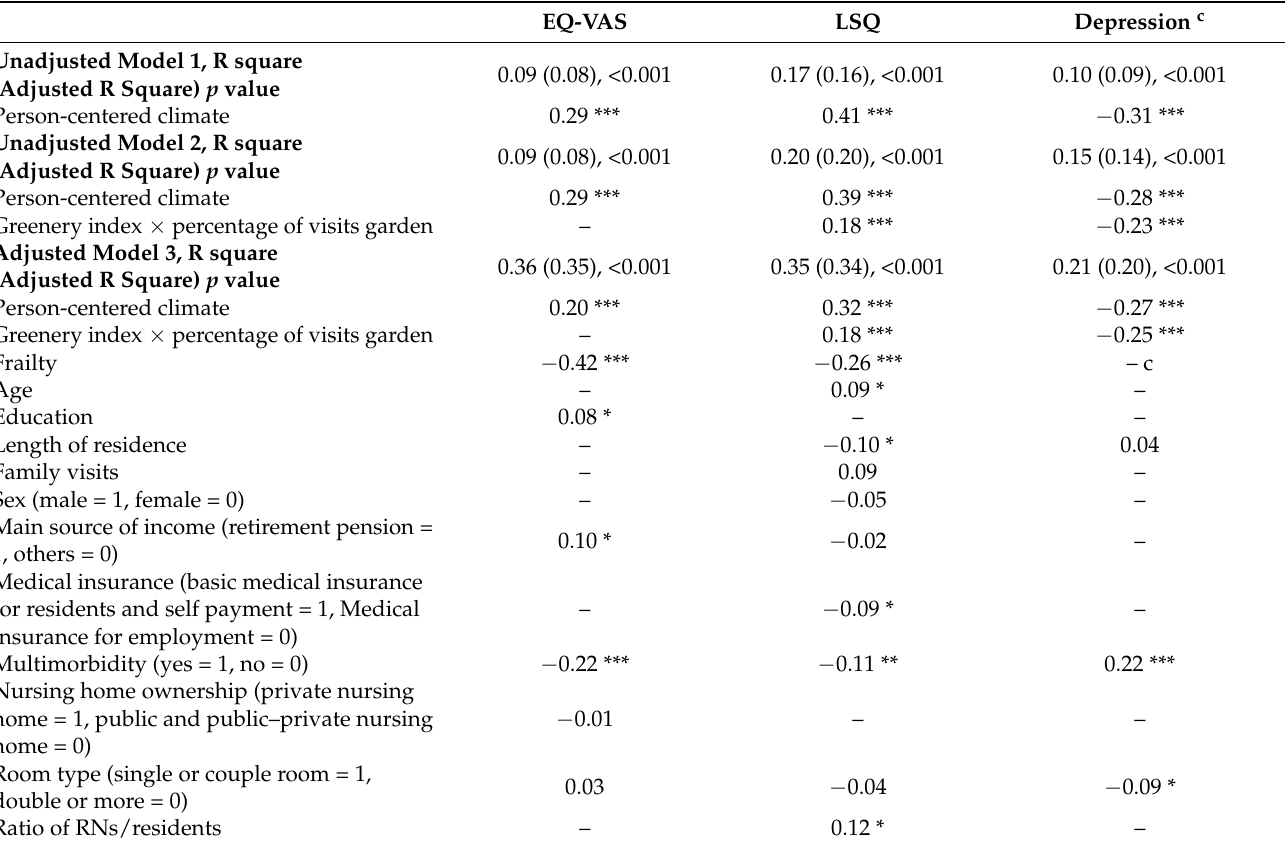
Table 4. Linear regression analyses with well-being as the dependent variable and person-centered climate and greenery as independent variables (Models 1–2), adjusted for personal characteristics and NH characteristics (model 3) a,b ( n = 470). EQ-VAS LSQ Depression